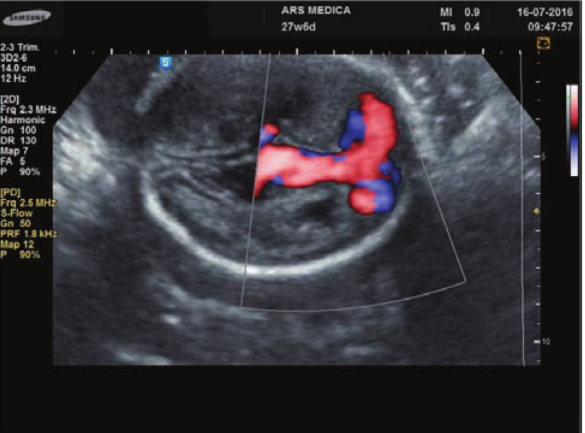
Figure 2: Fetal brain transverse view with color Doppler signal: showing turbulent blood flow inside tubular structure